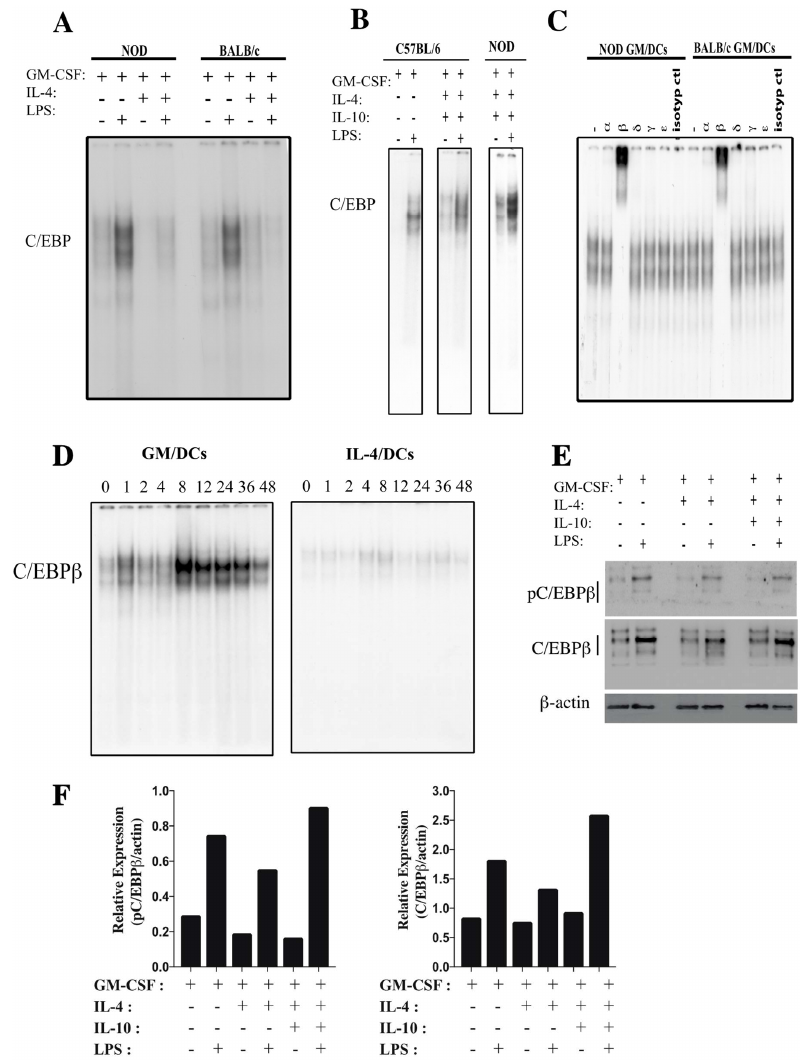
Figure 1. Increased C/EBPβ expression and DNA binding activity in LPS-stimulated GM/DCs. ( A ) Bone marrow-derived GM/DCs and IL-4/DCs were generated from NOD and BALB/c mice and left unstimulated or stimulated with LPS (1 μg/mL for 48 h). Nuclear extracts were subjected to EMSA assays to assess C/EBP binding activity. ( B ) Bone marrow-derived GM/DCs and IL-10/DCs (generated with GM-CSF + IL-4 + IL-10) from C57BL/6 and NOD mice were left unstimulated or stimulated with LPS (1 µ g/mL for 48 h). Nuclear extracts were prepared and C/EBP binding activity was determined by EMSA assays ( C ) Supershift analyses were performed with nuclear extracts obtained from LPS-stimulated GM/DCs of NOD and BALB/c mice, as described in the Material and Methods section of the body of the text. ( D ) C/EBP β DNA binding activity was monitored by EMSA, using nuclear extracts from LPS-stimulated GM/DCs and IL-4/DCs from NOD mice at the indicated times. ( E ) Western blot analysis of pC/EBP β (Thr188) and C/EBP β levels in cell lysates from LPS stimulated GM/DCs and IL-4/DCs. ( F ) Quantitative analysis of data in Figure 1E normalized to loading control ( β -actin). Data are representative of a minimum of 2–3 independent